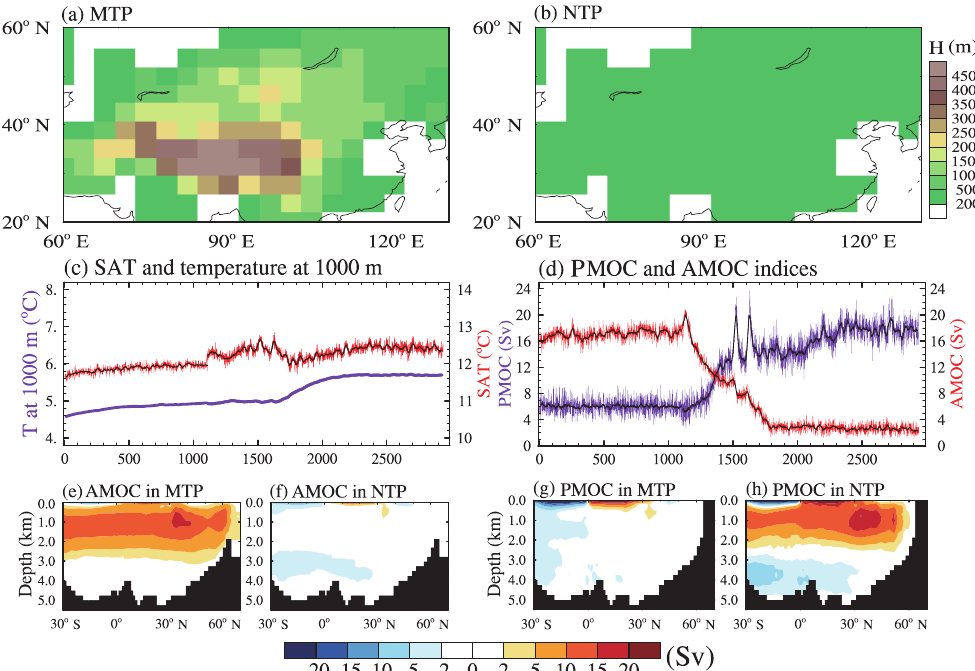
Figure 1. Two topographic height configurations used in experiments: (a) MTP and (b) NTP. (c) Time series of global mean annual 2m surface air temperature (SAT) and sea temperature at 1000m depth in the MTP (1–1100 years) and NTP (1101–2940 years) simulations; bold black lines show the 21-year running mean. (d) Same as (c) but for PMOC and AMOC indices. AMOC and PMOC indices are defined as the annual maximum of the meridional stream function value north of 28 ◦ N and below the depth of 500m over the North Atlantic and Pacific, respectively. (e–h) Climatological annual mean Atlantic and Indian–Pacific meridional overturning stream function in MTP (e, g) and NTP (f, h) ; positive (negative) shading represents clockwise (counterclockwise) circulations.